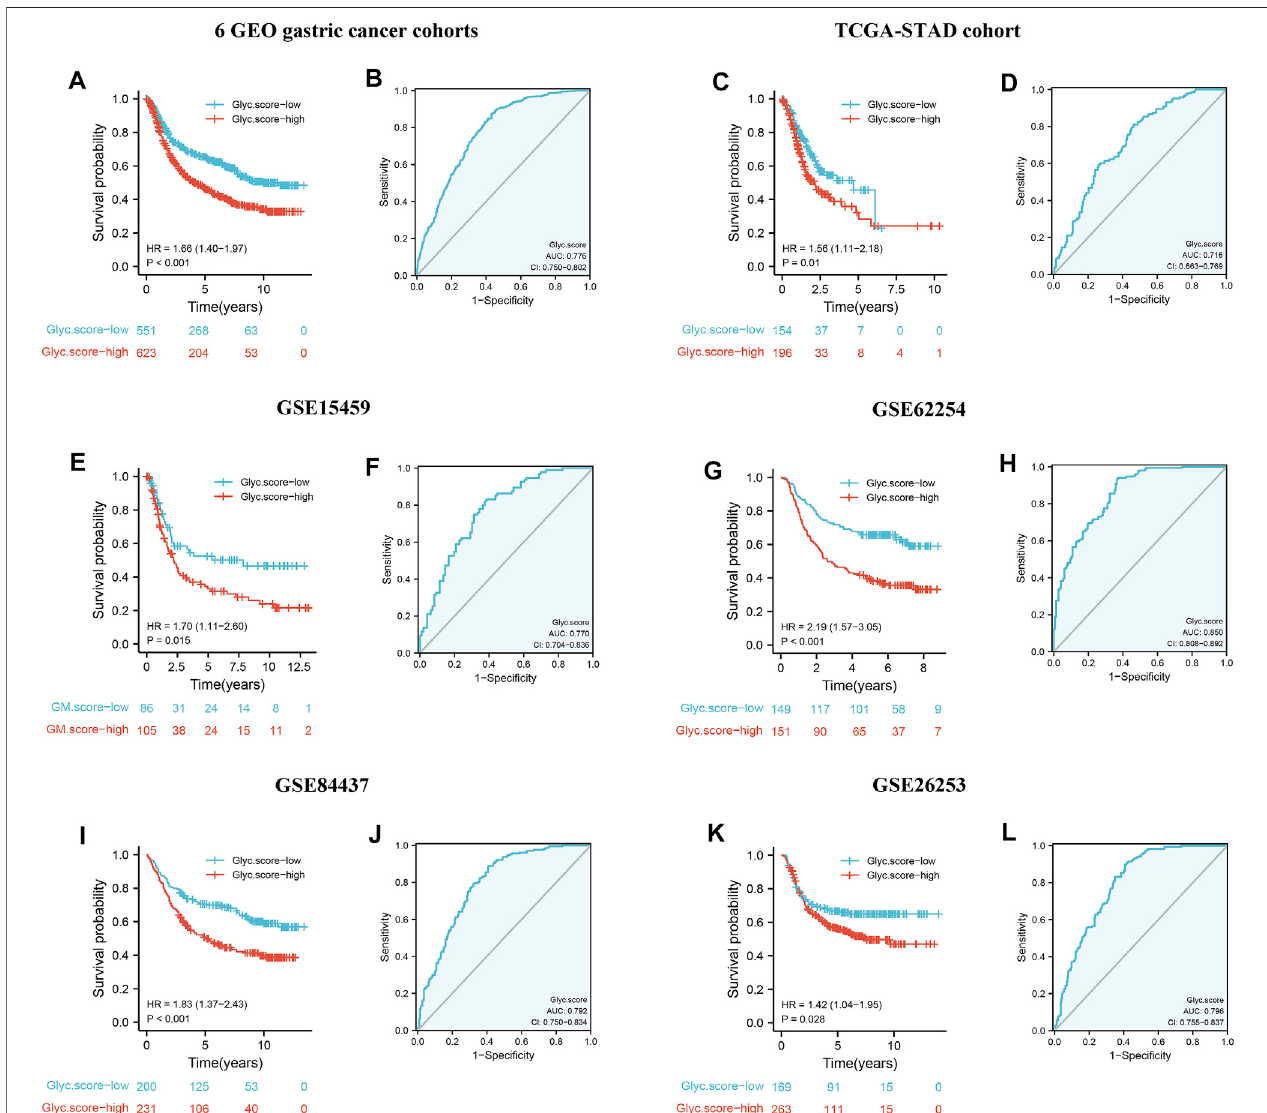
FIGURE 7 | External validation of Glyc. score model. (A) Kaplan – Meier curves for high – and low – Glyc. score patient groups in six GEO datasets (GSE84437, GSE34942, GSE15459, GSE57303, GSE62254, and GSE29272). (B) The predictive value of Glyc. score in six GEO dataset. (C) Kaplan – Meier curves for high – and low – Glyc. score patient groups in TCGA-STAD. (D) The predictive value of Glyc. score in TCGA-STAD. (E) Kaplan – Meier curves for high – and low – Glyc. score patient groups in GSE15459. (F) The predictive value of Glyc. score in GSE15459. (G) Kaplan – Meier curves for high – and low – Glyc. score patient groups in GSE62254. (H) ThepredictivevalueofGlyc.scoreinGSE62254. (I) Kaplan – Meiercurvesforhigh – andlow – Glyc.scorepatientgroupsinGSE84437. (J) ThepredictivevalueofGlyc. score in GSE84437. (K) Relapse-free survival analysis of Glyc. score in GSE26253 cohort. (L) The predictive value of Glyc. score in GSE26253.